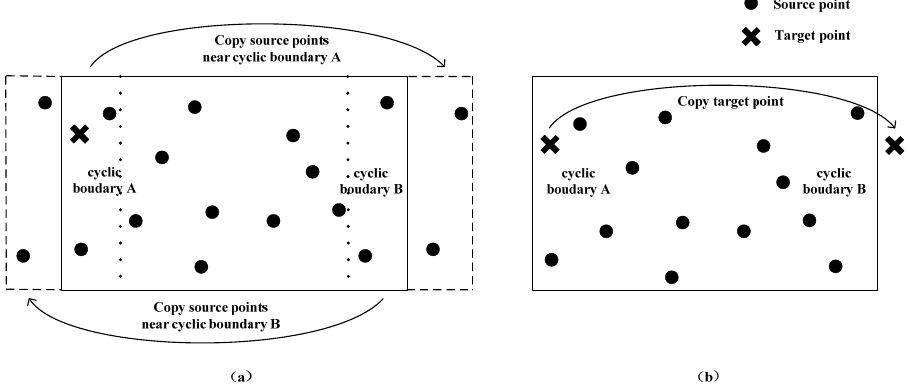
Figure 1. Schematic diagrams of the mirror methods. ( a ) is the mirror method based on source points duplication, and ( b ) is the mirror method based on target points duplication.